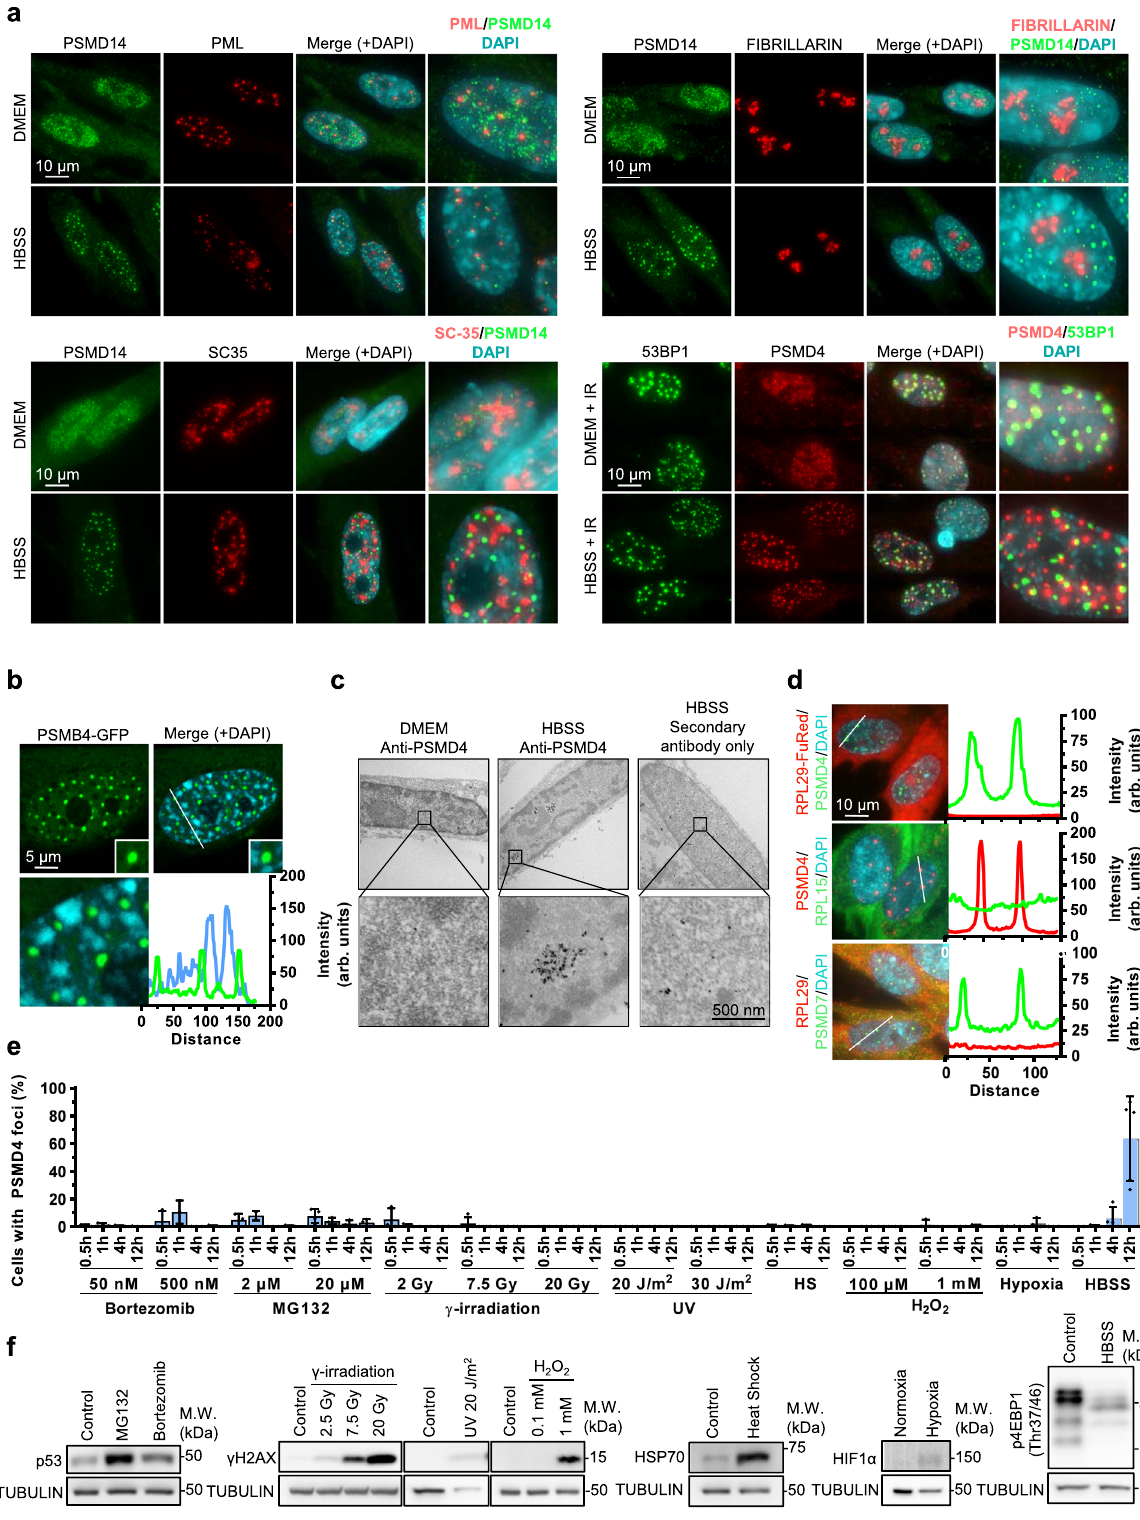
(Fig. 7g, j). Next, we reasoned that ubiquitin removal from SIPAN might, however, be required for SIPAN resolution upon incuba- tion in normal culture medium. Inhibition of the